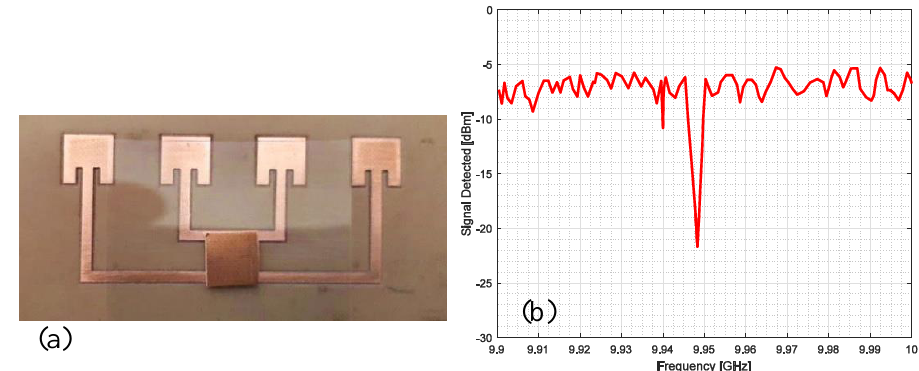
Figure 17. ( a ) Photo of a single-bit chipless Van Atta array RFID prototype fabricated on an FR4 dielectric substrate and equipped with a square patch resonator. ( b ) Measured signal from the prototype reported in ( a ).